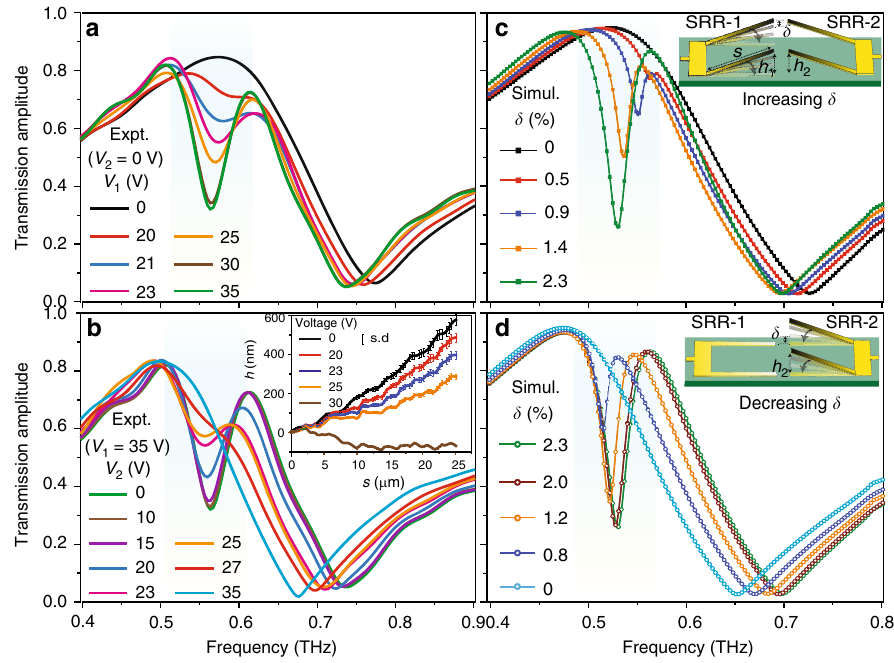
Fig. 2 Active tuning of Fano resonances in MEMS metasurface. a Depicts the experimentally measured THz transmission spectra showing the evolution of Fano resonance for continuous actuation of SRR-1 by varying voltage V 1 , while keeping V 2 = 0 V. b Represents the measured spectra resulting from the actuation of SRR-2 by increasing V 2 , while keeping V 1 = 35 V. Inset fi gure depicts the experimentally mapped actuation angles (with the error bars) of the SRR cantilevers of metal thickness 900 nm under the applied voltage ( V ) for the designed MEMS Fano-metasurface. c , d Numerically simulated THz transmission spectra for increasing and decreasing structural asymmetry con fi gurations of the proposed MEMS Fano-metasurface. The values of the depicted asymmetry parameter ( δ ) in ( c ) and ( d ) show one-to-one correspondence with the voltage values of V 1 and V 2 varied in ( a ) and ( b ), respectively. The insets in ( c ) and ( d ) signify the sequential actuation of SRR-1 and SRR-2, respectively, showing the increasing and decreasing structural